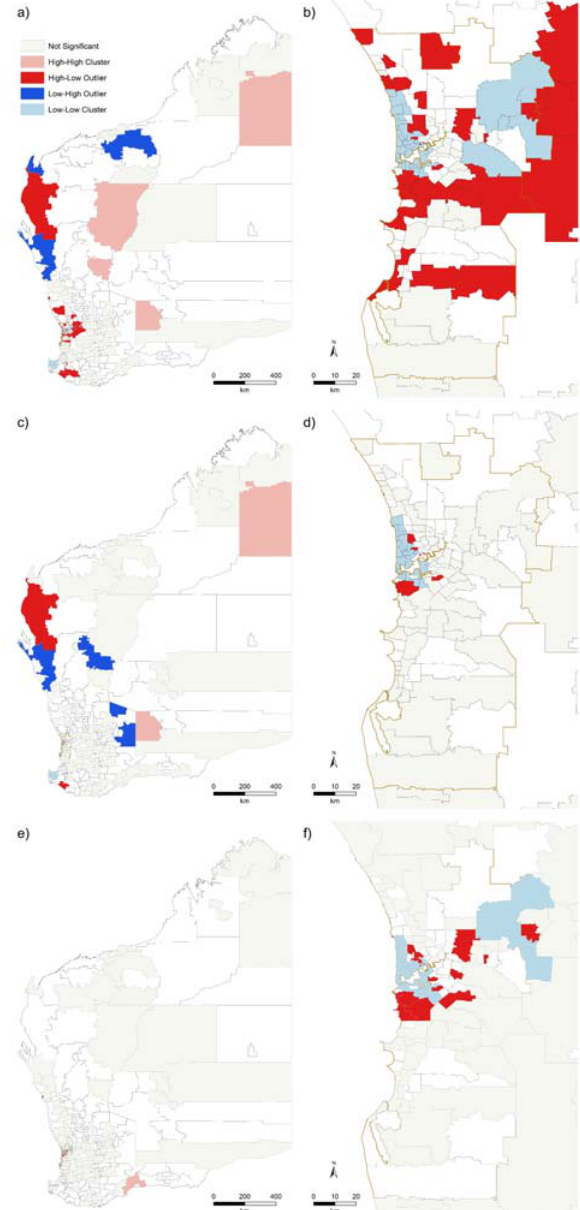
Figure 11. Local autocorrelation analysis of relationship of PHC to